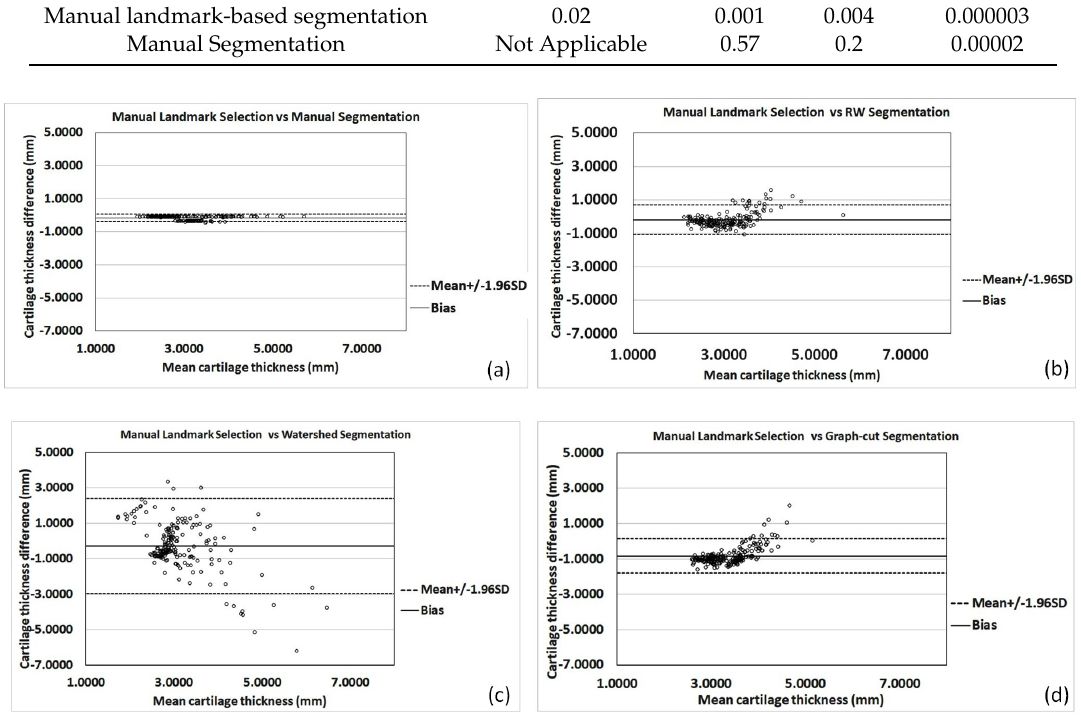
Figure 9. Bland–Altman plots for thickness comparison obtained with the ( a ) manual thickness computation, ( b ) RW, ( c ) watershed, and ( d ) graph-cut